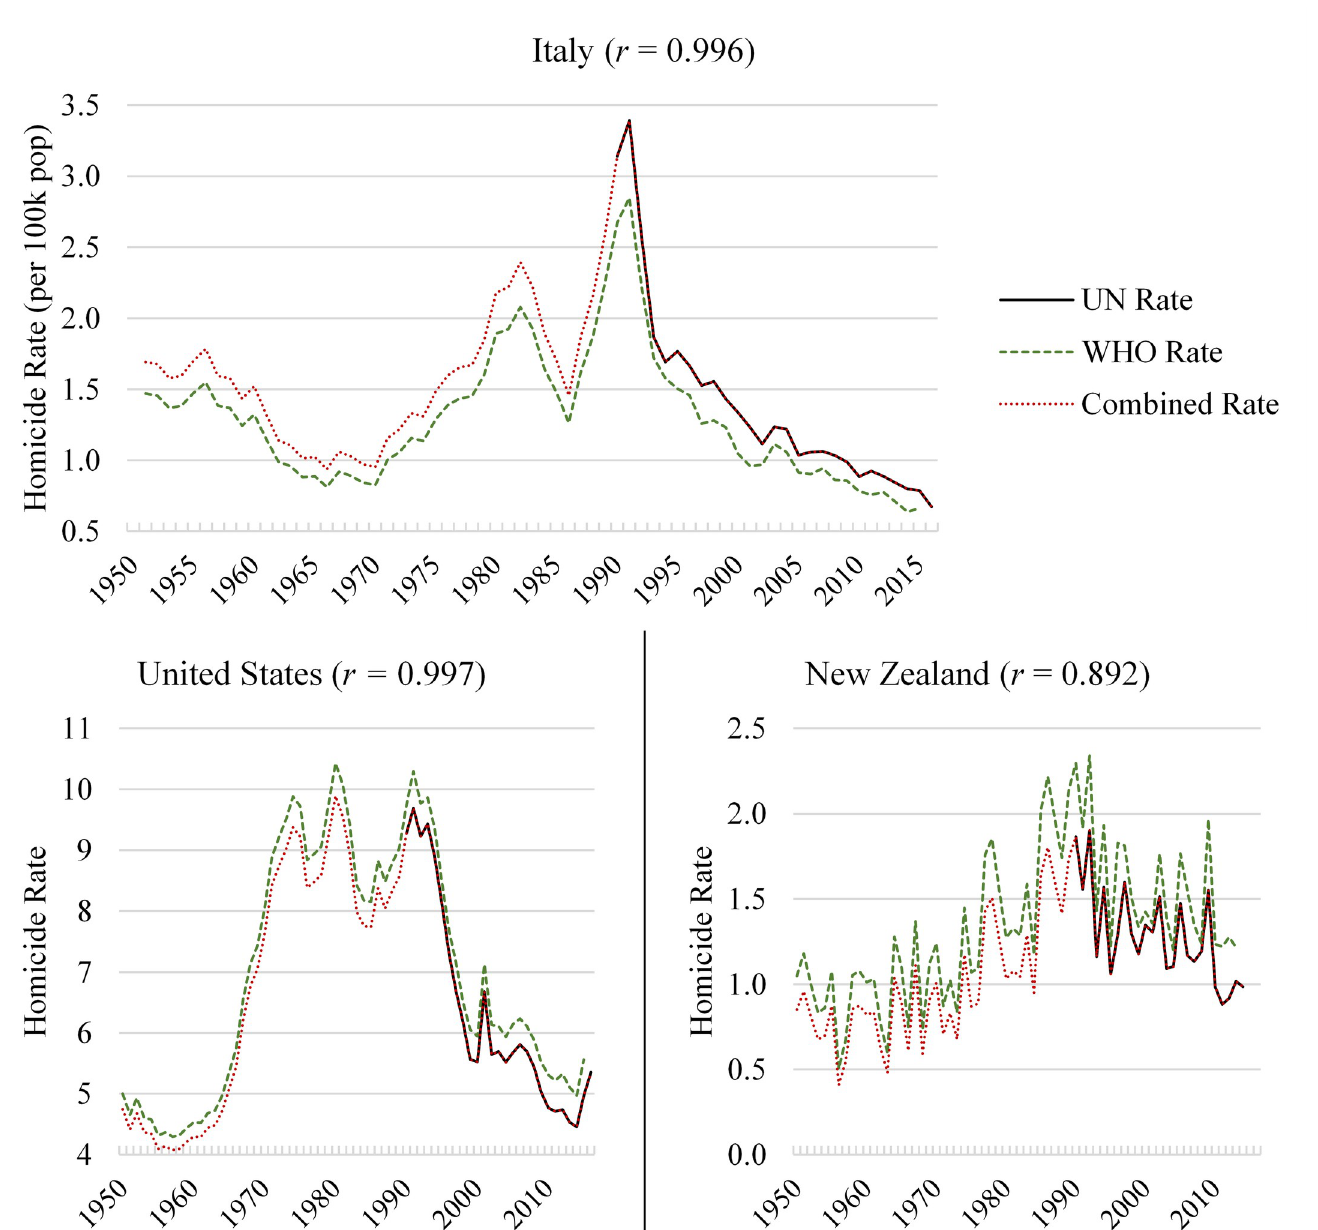
Fig 4. Combined homicide rate series– 1950 to 2015. Shown is the homicide rate from the United Nations Homicide Database since 1990, contrasted with the homicide rate from the WHO Mortality Database since 1950, and the Combined Series resulting from the combination between the two previous sources between 1950 and 2015 for Italy, the United States, and New Zealand. The Pearson correlation of overlapping years between the UN and the WHO homicide trends is in